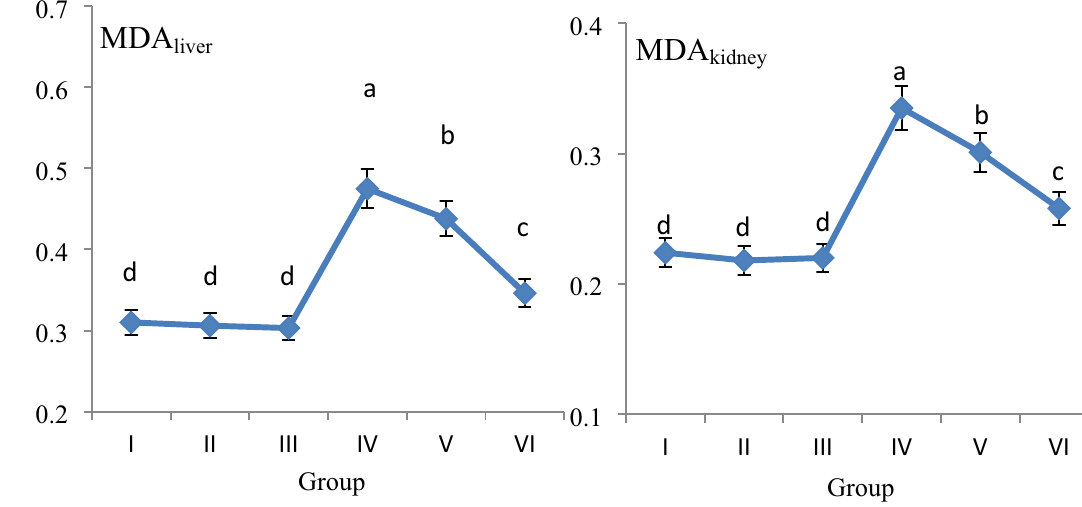
Figure 2. The effect of AFM 2 and quercetin on MDA levels (nmol/g). Group I: control, Group I: control, Group II: 25 mg/kg b.w quercetin, Group III: 50 mg/kg b.w quercetin, Group IV: 16 mg/kg b.w AFM 2 , Group V: 16 mg/ kg b.w AFM 2 + 25 mg/kg b.w quercetin, Group VI: 16 mg/kg b.w AFM 2 + 50 mg/kg b.w quercetin. Values are shown as mean ± SD (n = 6). Means shown with different letters (a–d) are statistically significant ( p < 0.05).